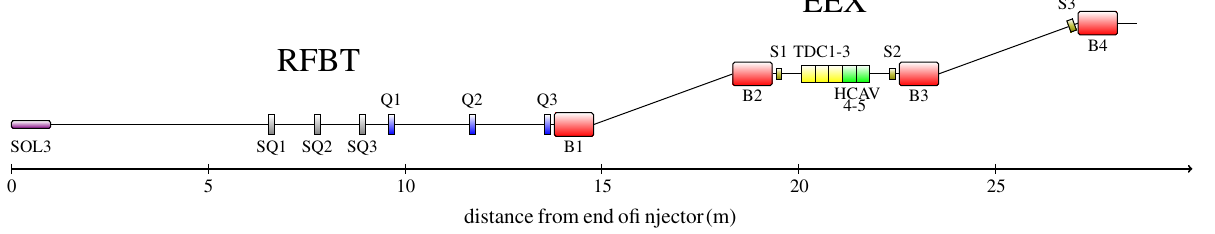
FIG. 2. Overview of the emittance manipulation beamline combining the RFBT (skew-quadrupole magnets SQ1, SQ2, and SQ3) and EEX (from dipole magnet B1 to B4) insertions. The label “ SQ i ” and “ Q i ” refer to skew- and normal-quadrupole magnets, “ B i ” and “ S i ” are dipole nd sextupole magnets. The elements ” TDC i ” and “ HCAV i ” refer to transverse-deflecting and 3.9-GHz SRF cavities; “ SOL3 ” is a solenoidal magnetic